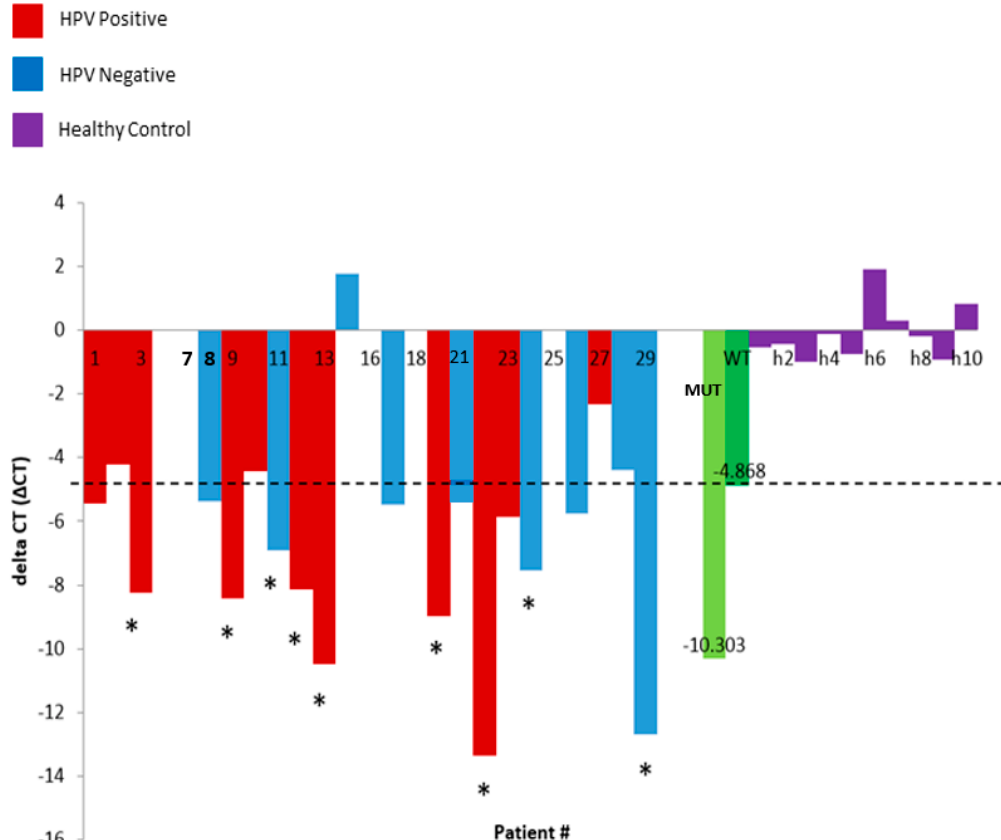
Figure 1. The bar graph showing the delta Ct ( ∆ CT) of HPV Positive (Red) and HPV Negative (Blue) plasma samples, w/high frequency of mutation in the positive control (MUT—light green) and a low mutation call in a wild type negative control (WT—dark green), and healthy control samples (purple: h1–h10). Samples found above the WT ∆ CT (represented by the dotted line) are positive for the E545K somatic mutation. Asterisk (*) indicates samples which are above the ∆ CT threshold, hence will likely harbour the E545K somatic mutation; samples at and/or below the threshold are less likely to be positive. Patient # correspond to the individual patient numbers.